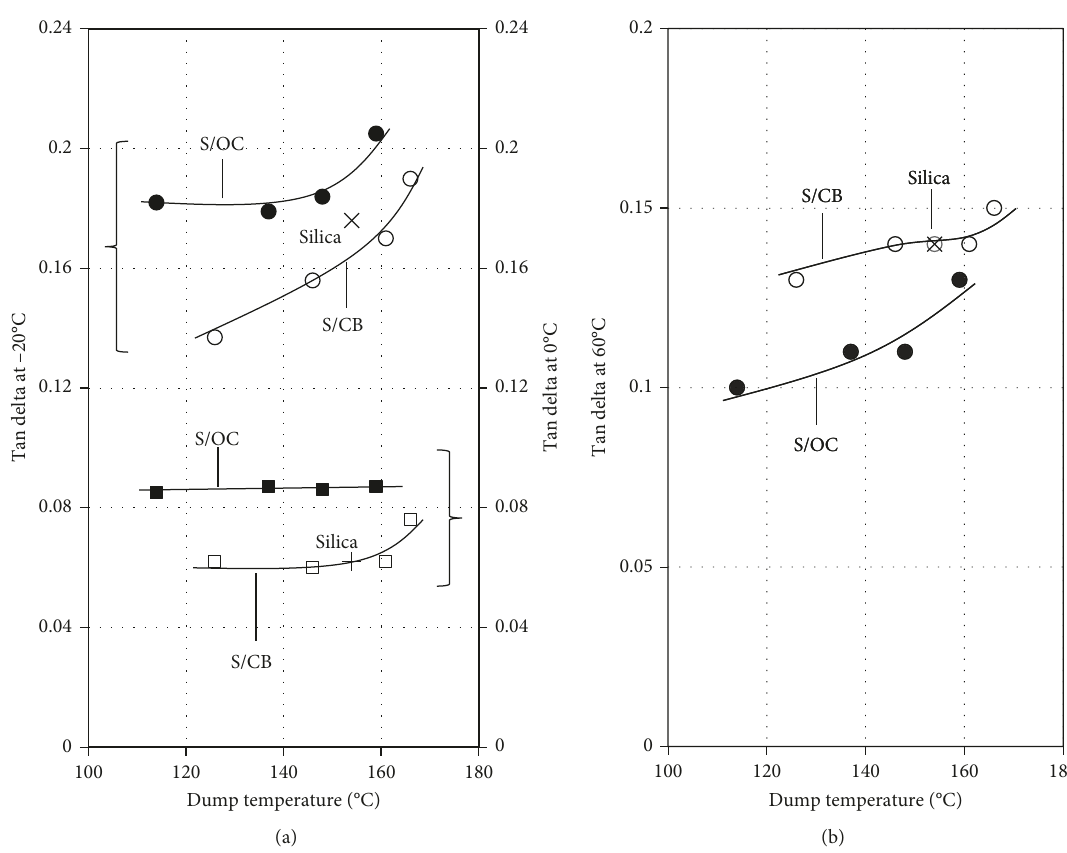
Figure 5: Influence of dump temperature on (a) tan delta at − 20 and 0 ° C from DMA and (b) tan delta at 60 ° C from RPA of silica-filled NR compounds containing different secondary fillers: carbon black (CB) or organoclay